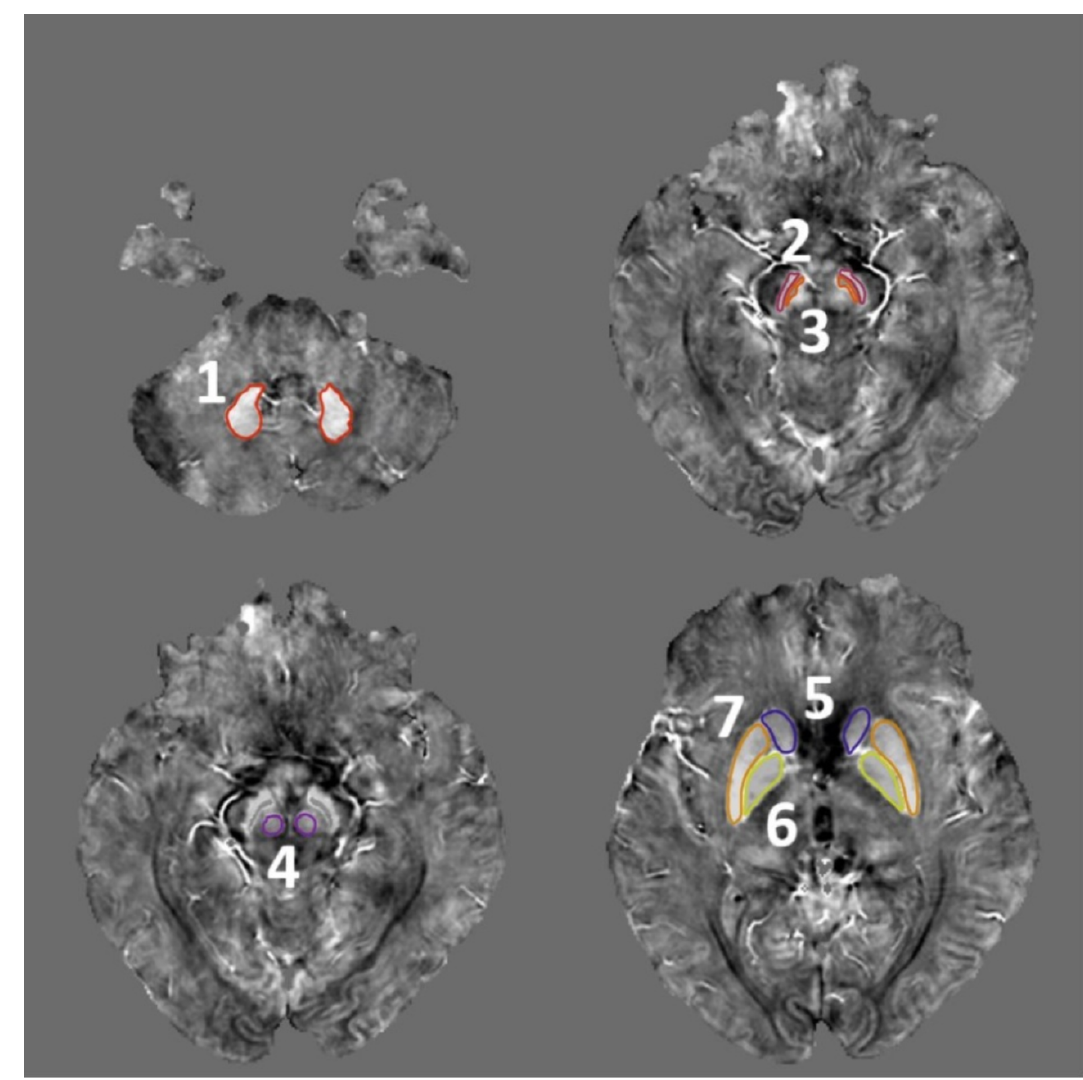
Figure 1. Manually segmented regions of interest. 1, Dentate nucleus; 2, substantia nigra pars compacta; 3, substantia nigra pars reticulata; 4, red nucleus; 5, caudate nucleus; 6, globus pallidus; 7, putamen.